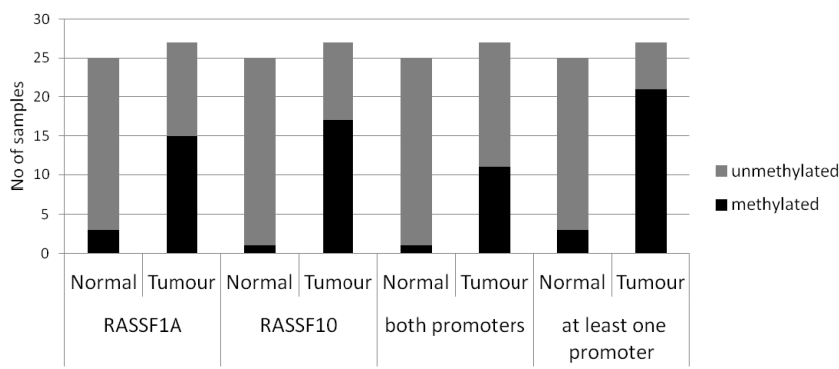
Figure 3. Promoter methylation summary of RASSF1A and RASSF10 for single promoter methylation, both promoter methylation and number of samples that showed at least 1 methylated promoter. Statistically significant for all tumour vs. normal samples (Fisher Exact Test, two tailed).